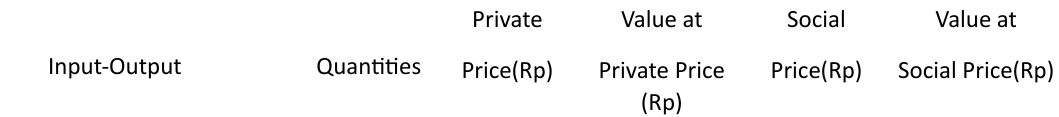
Table 4: Costs, Revenues, and Profit of Soybean Farming,